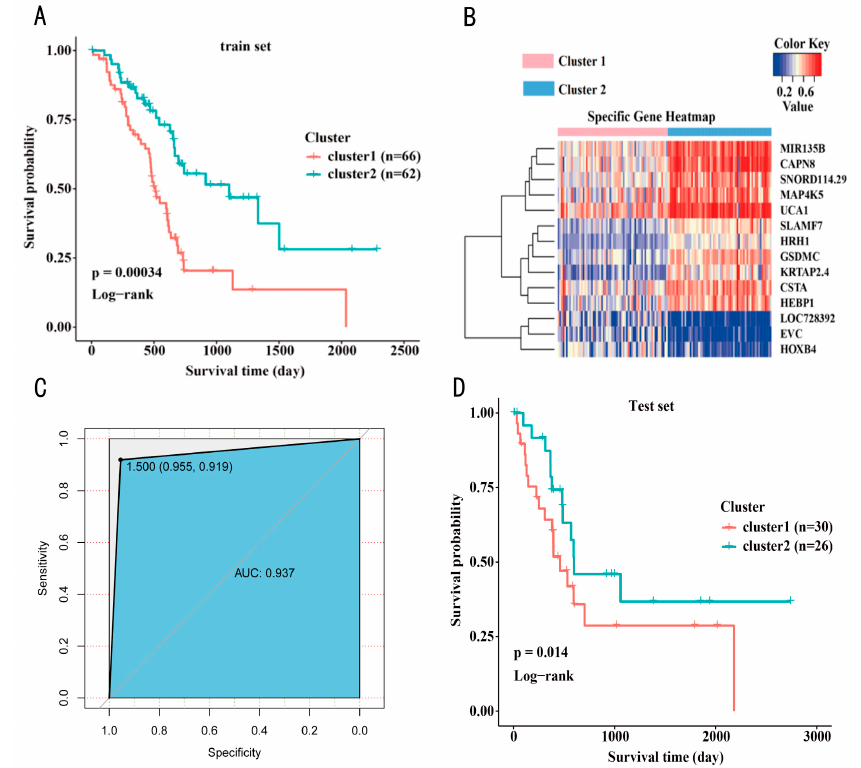
Figure 3. ( A ) Survival curves of two DNA methylated molecular subtypes in the training set. ( B ) Methylation levels of specific genes in two DNA methylation molecular subtypes. ( C ) The specificity and sensitivity of the predictive model. ( D ) The survival curves of the two DNA methylated molecular subtypes in the test set.